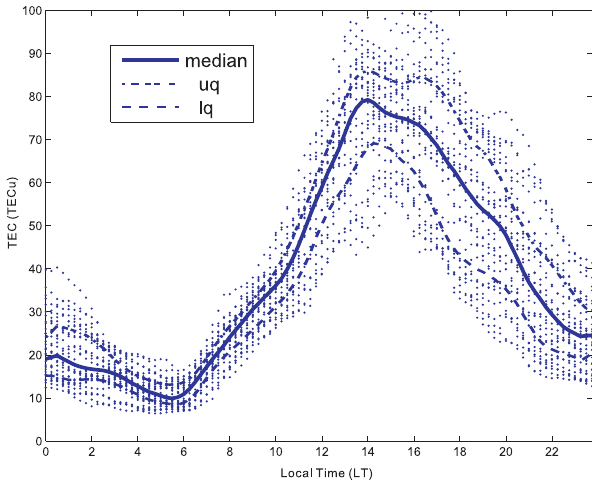
Fig. 3. Diurnal variations of TEC at Guangzhou (Guan) in March 2004 (the solid line is the median TEC value, the dotted one is the UQ value and the dashed one is the